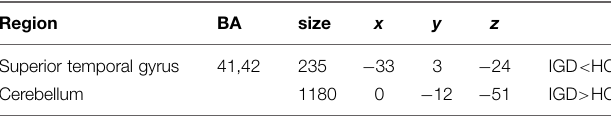
TABLE 1 | Brain regions with a main effect of group. Region